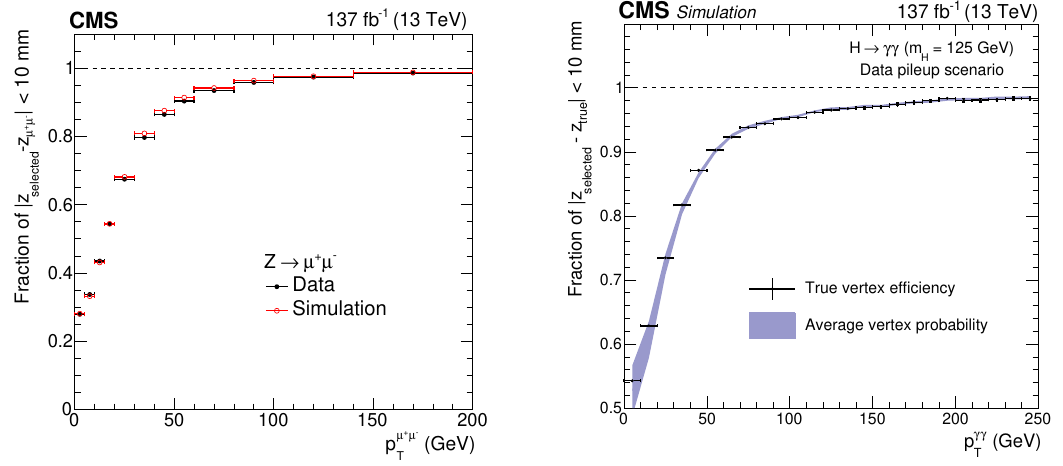
Figure 4 . The left plot shows the validation of the H → gg vertex identification algorithm on Z → m + m − events, where the muon tracks are omitted when performing the event reconstruction. This allows the fraction of events with the correctly assigned vertex estimated with simulation to be compared with data, as a function of the p of the dimuon system, serving as a validation of the T vertex identification BDT. Simulated events are weighted to match the distributions of pileup and distribution of vertices along the beam axis in data. The right plot demonstrates that the average vertex probability to be within 1 cm of the true vertex agrees with the true vertex efficiency in simulated events. The full data set collected in 2016–2018 and the corresponding simulation are